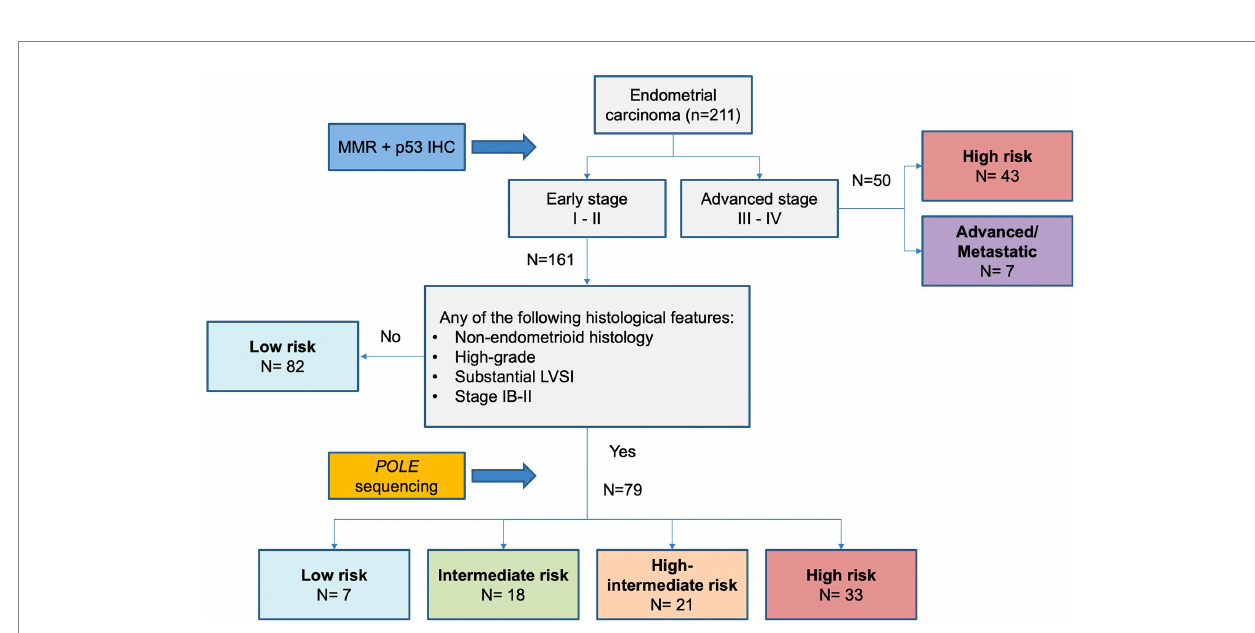
FIGURE 5 Proposed algorithm based on histopathologic parameters to select only those cases that need molecular analysis for the proper definition of